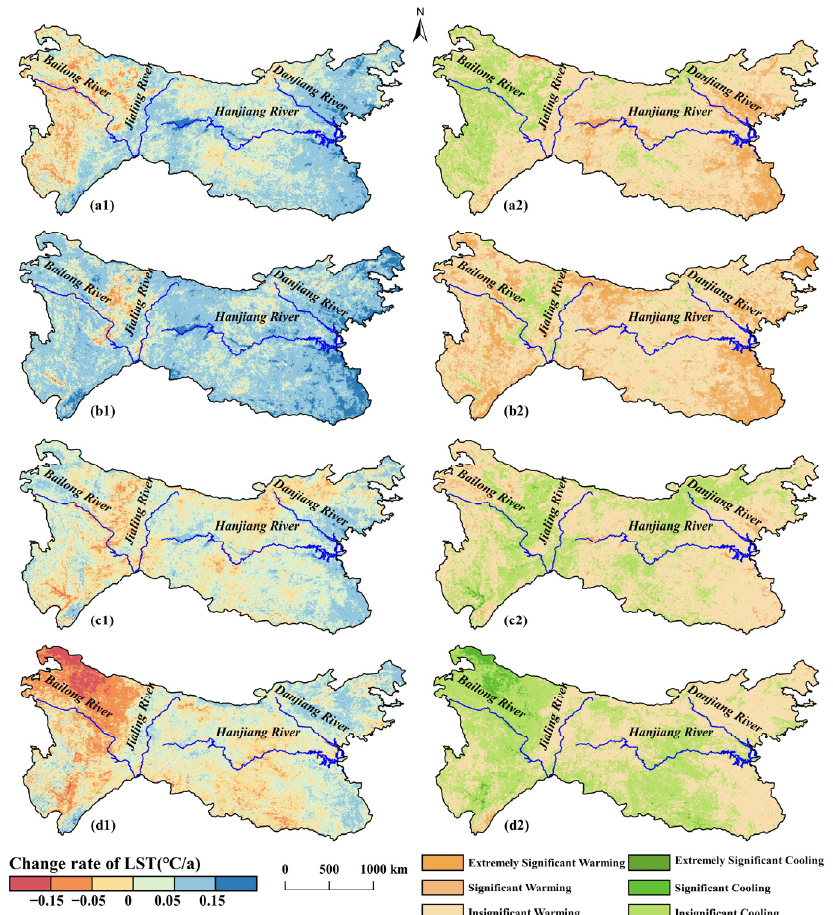
Figure 7. The interseasonal variability rates (slope) and trend significance of LST in spring ( a ); summer ( b ); autumn ( c ); and winter ( d ) in the Qinling-Daba Mountains from 2000 to 2020. ( a1 – d1 ) show the spatial distributions of the slopes in the four seasons; and ( a2 – d2 ) show the spatial distributions of the trend significance in the four seasons.